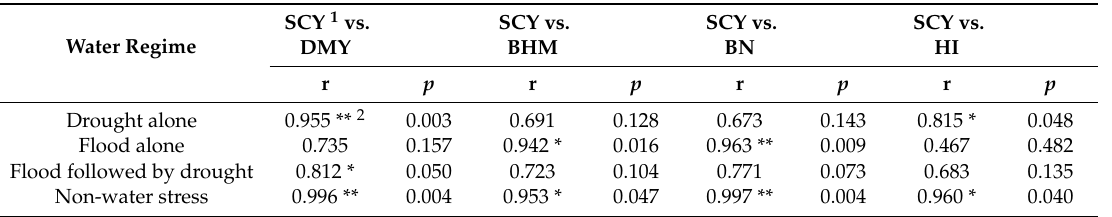
Table 4. The Pearson correlation coe ffi cients (r) and p values of the correlation analysis between seed cotton yield and relevant yield indices. SCY vs. SCY vs. SCY 1 vs. Water Regime BHM DMY